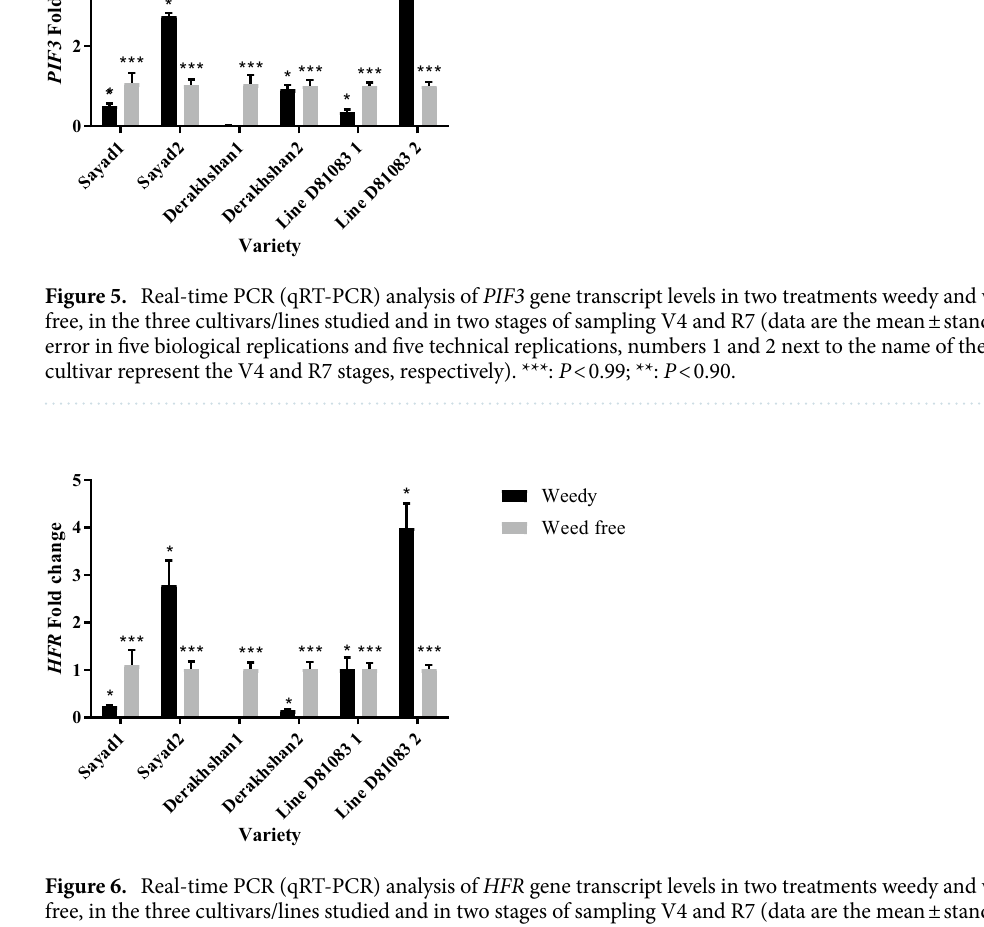
(Fig. 7). The highest HAT4 expression at the V4 stage was observed in the Derakhshan cultivar (0.509 times) while its lowest expression level was recorded in the Sayad cultivar (0.018 times). At the R7 stage, the expression of this gene increased with prolonging the weed interference duration. A significant rise was detected in the expression of this gene in Sayad cultivar and line D81083 exposed to complete weed interference increased but decreased while the Derakhshan cultivar showed a decline. The highest and lowest expression of the HAT4 gene at the R7 stage were 5.167 and 0.653, respectively, observed in line D81083 and Derakhshan cultivar. Investigation of the expression of the PAR1 gene (rapid regulation of phytochrome) under complete weed interference at the V4 stage indicated decreased expression in the three studied cultivars/lines (Fig. 7). The highest and lowest expression of the PAR1 gene at the V4 stage was observed in the Sayad cultivar (0.75 times) and the D81083 line (0.12 times), respectively. The expression level of this gene increased at the R7 stage by prolonging the weed interference period in the Derakhshan cultivar and D81083 line; while showing a decline in the Sayad cultivar. Decreased PAR1 gene expression was observed under complete weed interference in Sayad cultivar (0.23 times) and D81083 line (0.25 times) whereas Derakhshan cultivar exhibited an increase (3.44 times). Physiological traits. Antioxidant enzymes. Weed interference treatment with 0.0127 enzyme units per mg of protein led to the highest level of catalase in the V4 stage (Fig. 8A). The catalase and ascorbate peroxidase contents of the R7 stage were not affected by any of the treatments. At the V4 stage and under weed interference, the ascorbate peroxidase content (0.0599 units of enzyme per mg of protein) decreased compared to weed con- trol conditions (0.03047 units of enzyme per mg of protein) (Fig. 8B). At full interference with weeds and the V4 stage, the Derakhshan cultivar showed the highest superoxide dismutase content (12.525 enzyme units per gram of plant material) while the Sayad cultivar demonstrated the lowest amount of this enzyme (7.5608 enzymatic units per gram of plant material) (Fig. 8D). At the R7 stage,